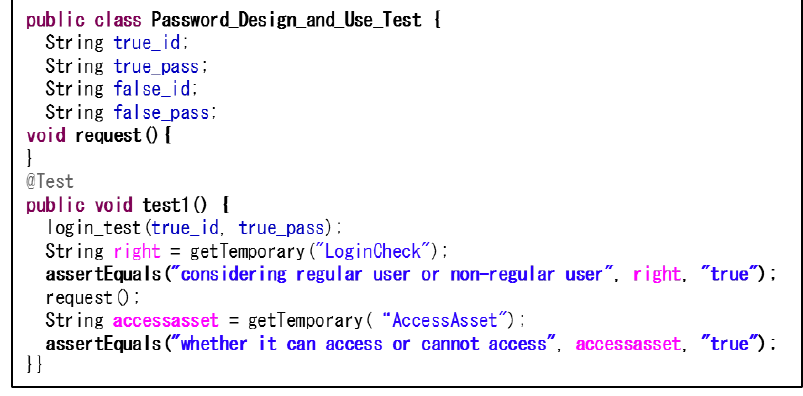
Figure 11. Part of the test case template.